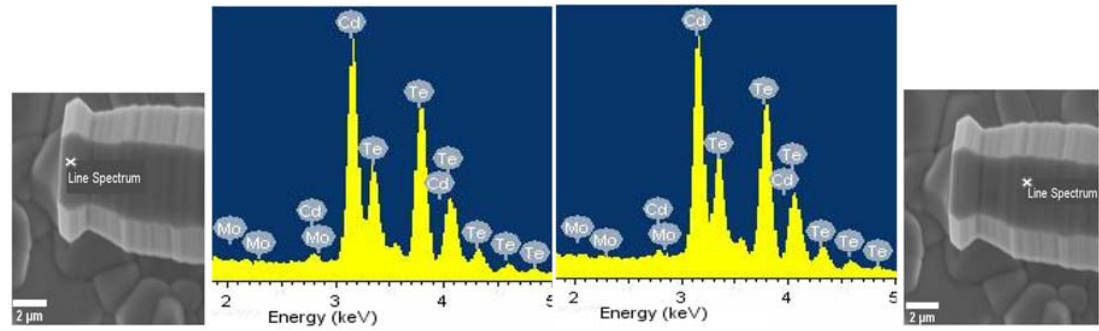
Figure 4. SEM images of the CdTe wires deposited under vacuum on Mo/SLG and EDX spectra at different points of the wires.